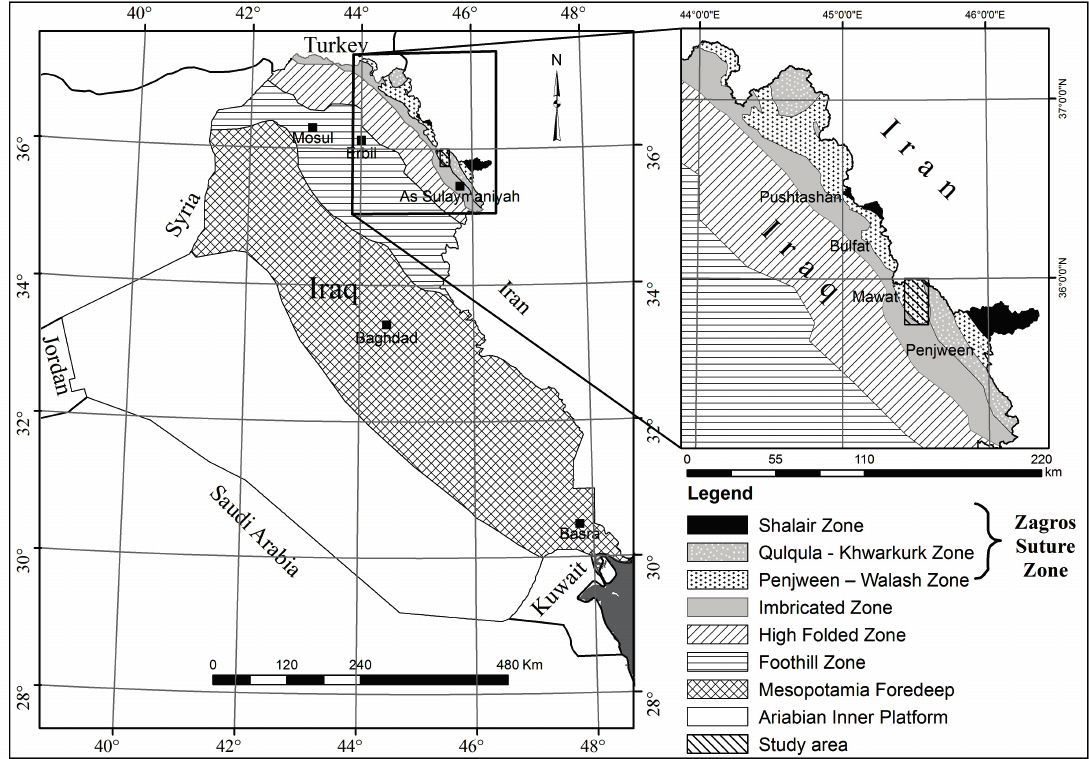
Figure 1. Location map of the study area showing the tectonic map and the four intrusive ophiolite complexes of Mawat, Penjween, Pushtashan and Bulfat in Iraqi part of the Zagros Suture Zone (modified after